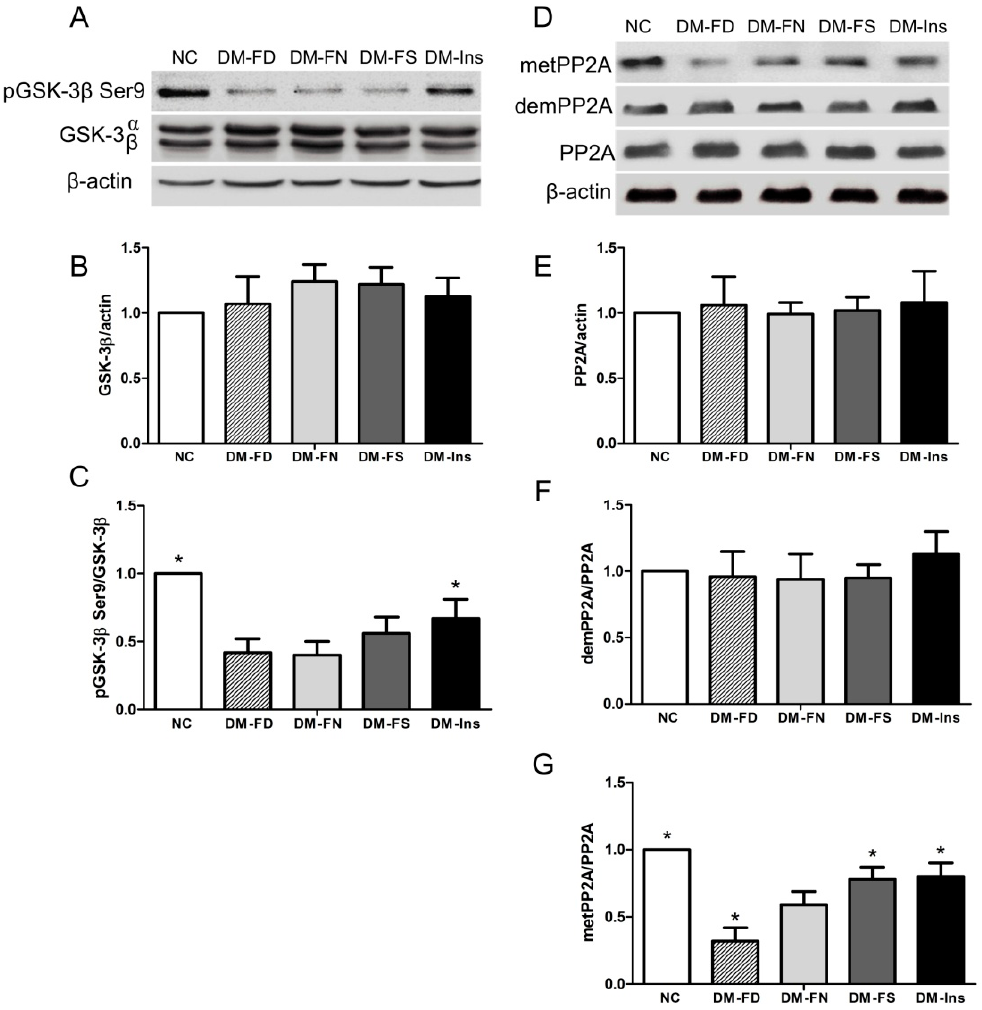
Figure 3. Effect of folic acid on GSK-3 β and PP2A peptides in STZ-treated mouse brains. Representative Western blot image of p-GSK-3 β (Ser9), GSK-3 β and β -actin respectively ( A ); Quantified results of GSK-3 β was normalized to β -actin ( B ); Relative expression level of p-GSK-3 β (Ser9) was normalized to GSK-3 β expression ( C ); Representative Western blot image of anti-methylated, anti-demethylated and total PP2A ( D ); histograms showing semi-quantitative analyses of anti-methylated ( E ), anti-demethylated ( F ) and total PP2A ( G ). The data were expressed as means ± SD values, n = 5 animals/group. * p < 0.05 versus the DM-FN group. PP2A, protein phosphatase 2A; GSK-3 β , glycogen synthase kinase 3 β .